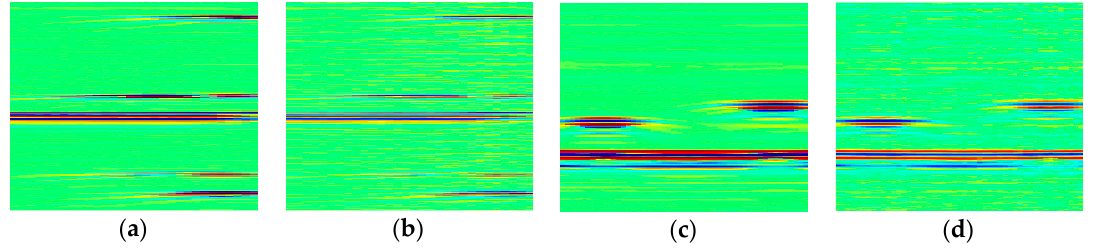
Figure 17. The original 50 MHz SR experimental image of ( a ) EDM notches, ( c ) flat-bottom holes and the reconstructed results in time domain, ( b ) CR = 60%, PSNR = 35.46 dB ( d ) CR = 60%, PSNR = 35.96 dB.